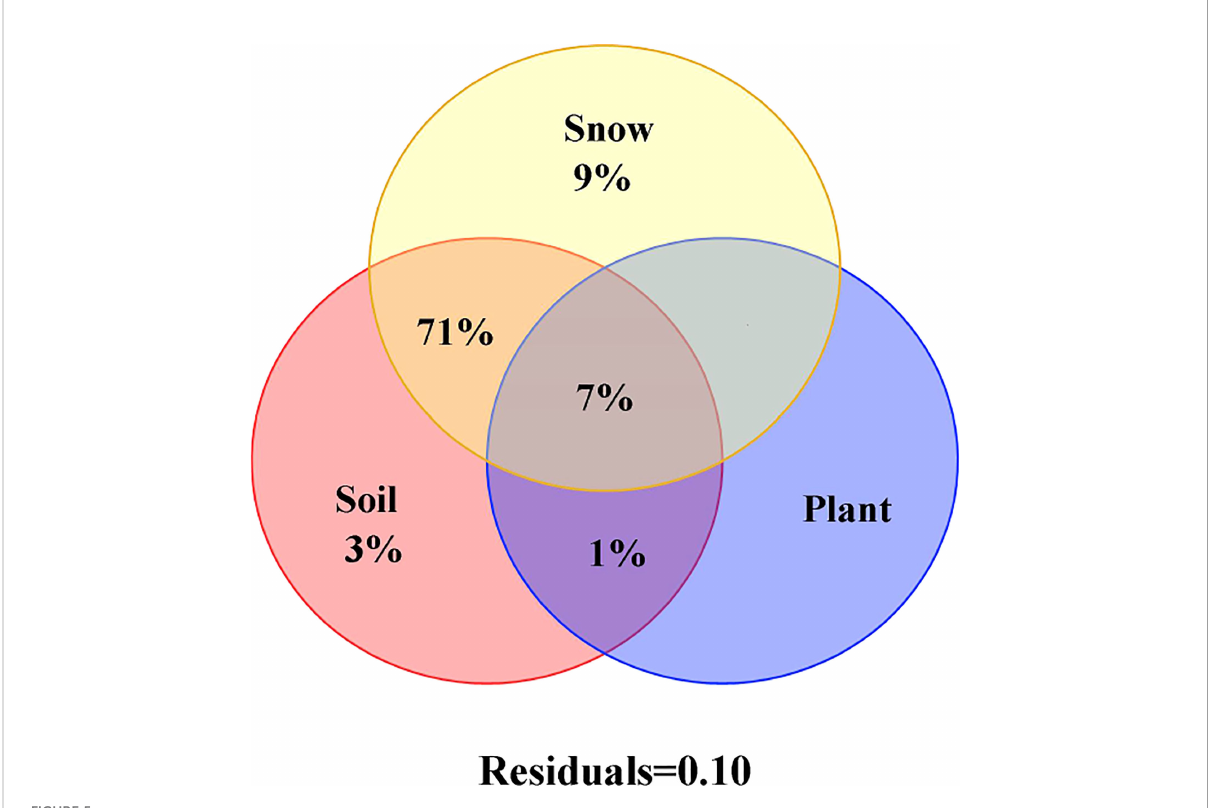
FIGURE 5 In fl uence factors of NSC, soluble sugar, starch and the ratio of soluble sugar to starch of Syntrichia caninervis on 7-year continuous snow cover change by the variance decomposition analysis.